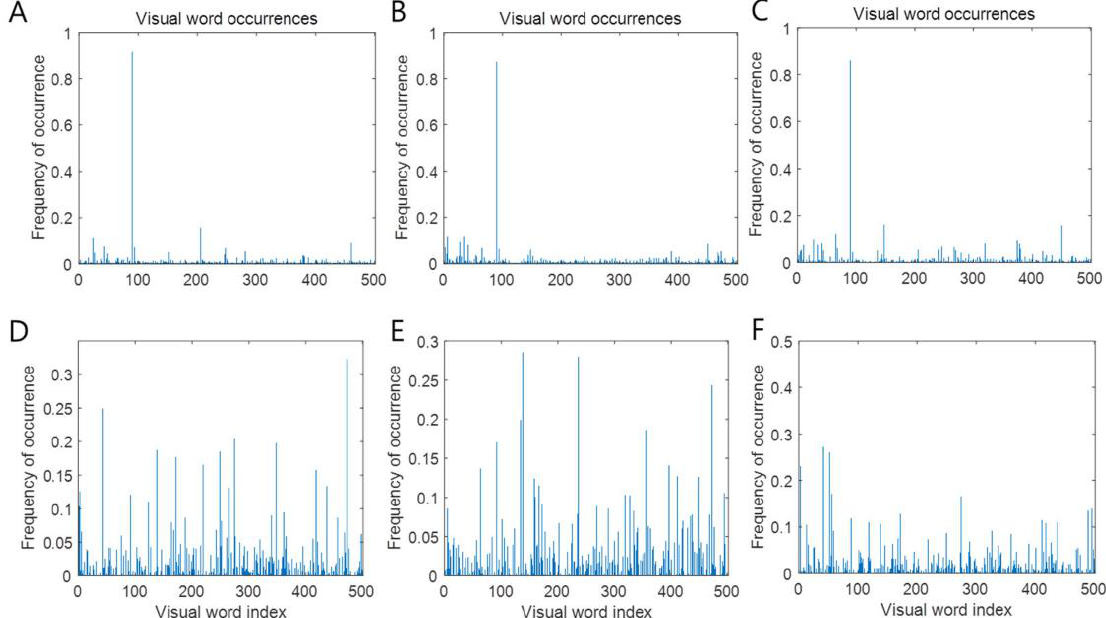
Figure 2. Visual word occurrence of each label. HLD L4/5 patients undergoing DITI anterior ( A ), feet ( B ), and posterior ( C ) and HLD L5/S1 patients undergoing DITI anterior ( D ), feet ( E ), posterior ( F ). Visual word index and frequencies showed characteristics of each image using the bag of visual word image classification algorithm.